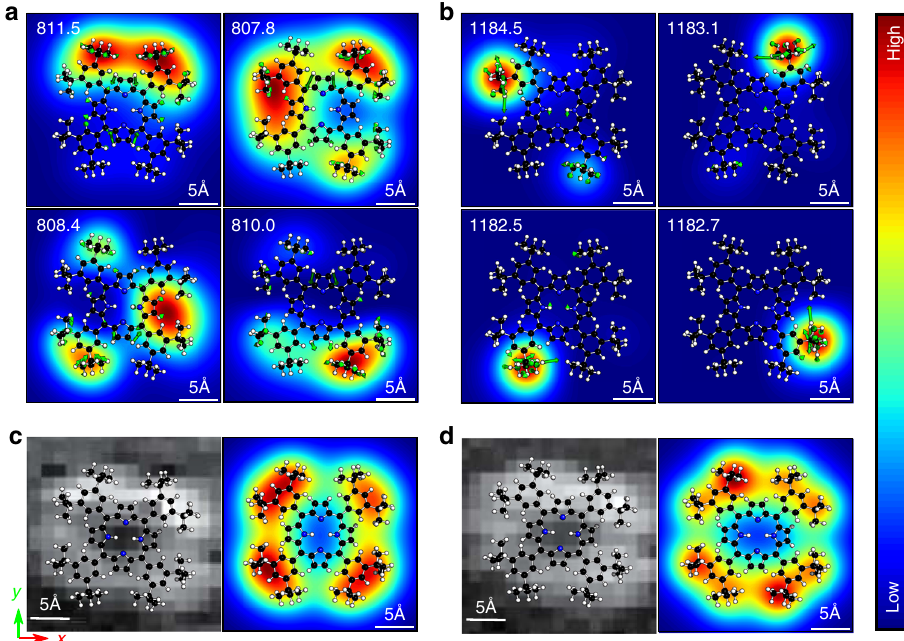
Fig. 4 The resonant TERS images of H 2 TBPP molecule absorbed on a Ag(111) surface. The excitation energy corresponds to the B y transition. a , b TERS images of individual degenerate modes of the bands centered around 810 and 1185 cm − 1 . The schematic representations of molecular vibrations lay on the individual TERS images and the corresponding frequencies (in cm − 1 ) are given in the top left corners. c , d The experimental TERS images (left panel) and simulated TERS images by integrating band width of 20 cm − 1 (right